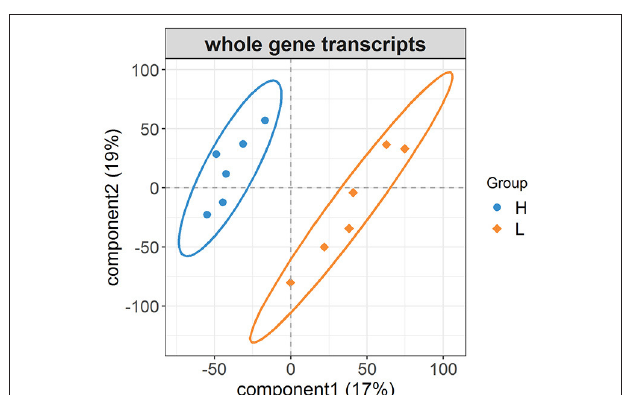
FIGURE 2 | The changes in whole gene transcripts between the H and L groups. PLS-DA plot of whole gene transcripts indicating the significant differentiation of gene expression profiles between the H and L